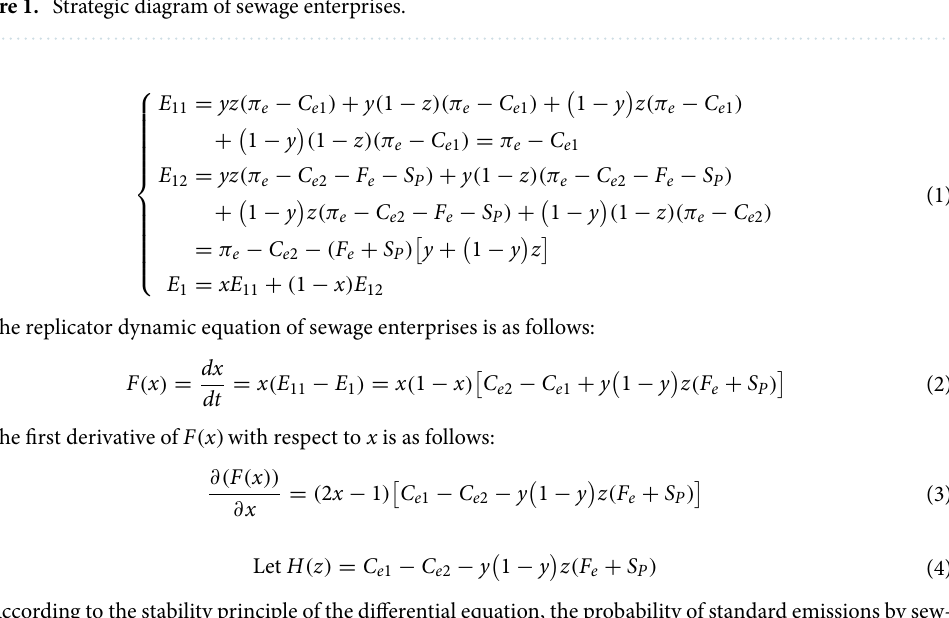
Figure 1. Strategic diagram of sewage